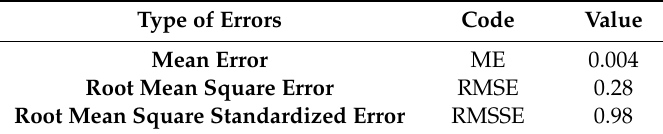
Table 3. Cross-validation (CV) error values.